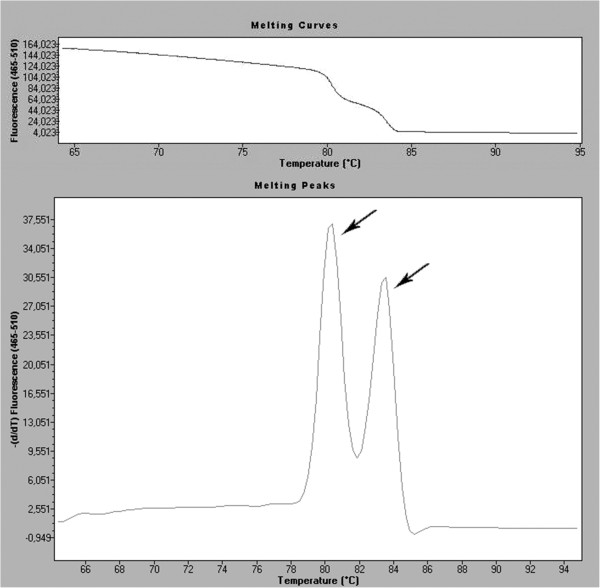
Melting curve and melting peaks charts of a heterozygous mutation in exon 23 in NF-1 (neurofibromatosis 1) gene during screening by HRMA.